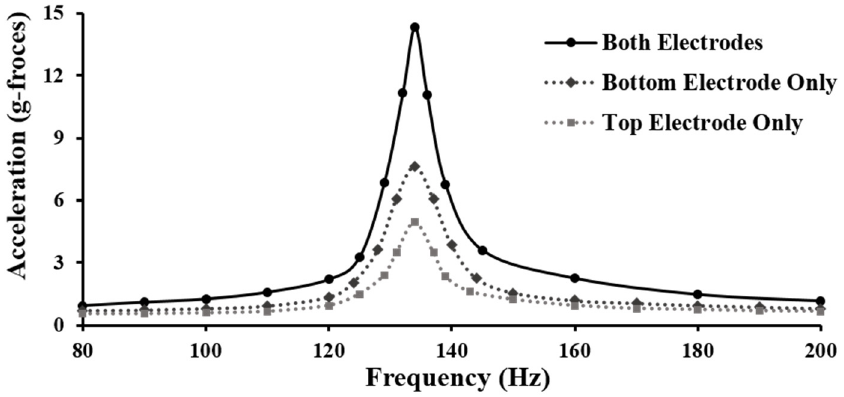
Figure 8. Experimental acceleration response of the dual-electrode actuator powering the bottom, top, and both electrodes.